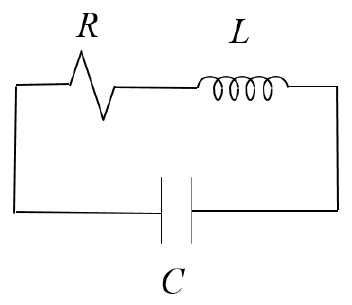
Figure 10. Equivalent model of a coil.